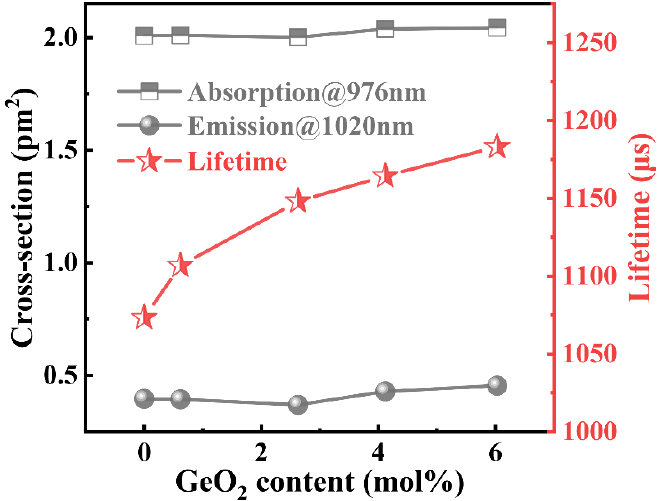
Figure 5. Absorption, emission cross-section, and fluorescence lifetime of Yb 3+ ions in pristine GAY samples.